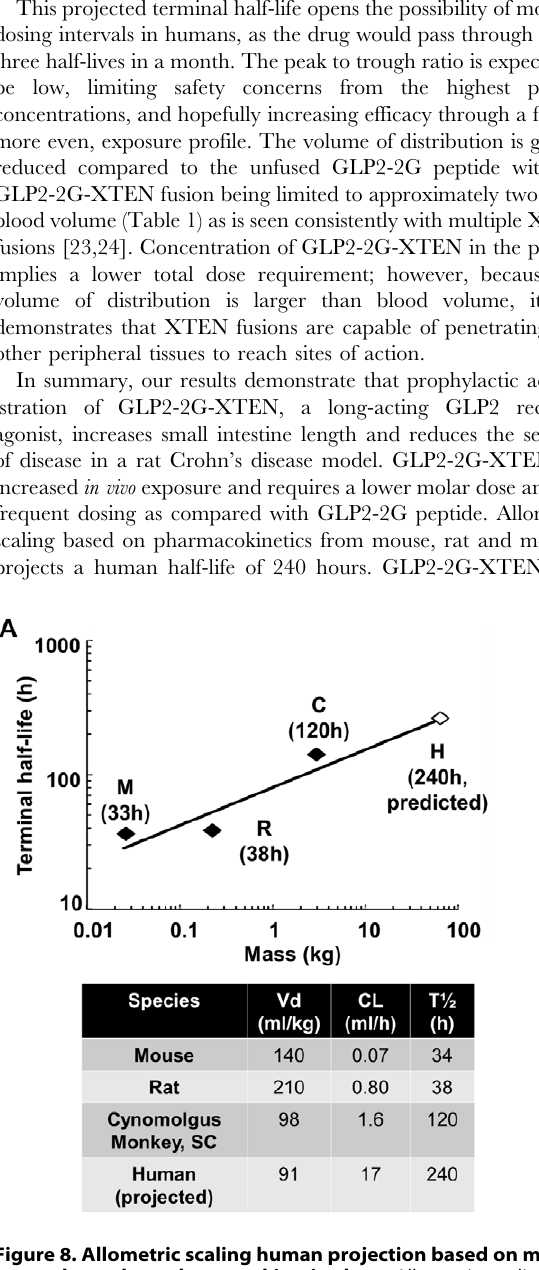
hours, in good agreement with the allometric scaling projection.